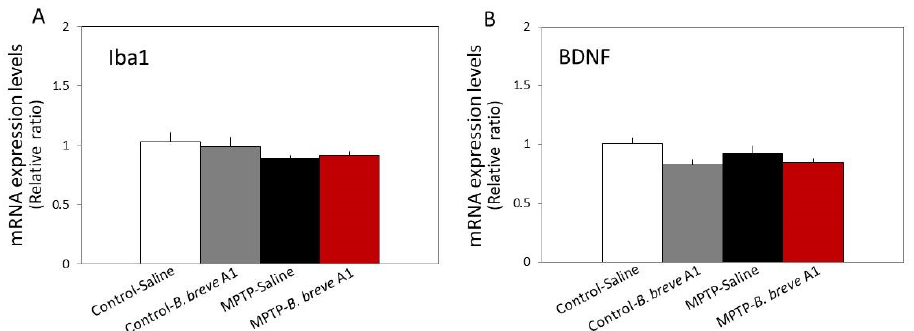
Figure 5. RT–qPCR analysis of the hippocampal mRNA expression levels of Iba1 ( A ) and BDNF ( B ) in saline-administered controls and PD mice, and in B. breve A1-administered controls and PD mice. Data are expressed as the mean ± SEM: n = 8–10 per group. No significant differences were observed between groups.